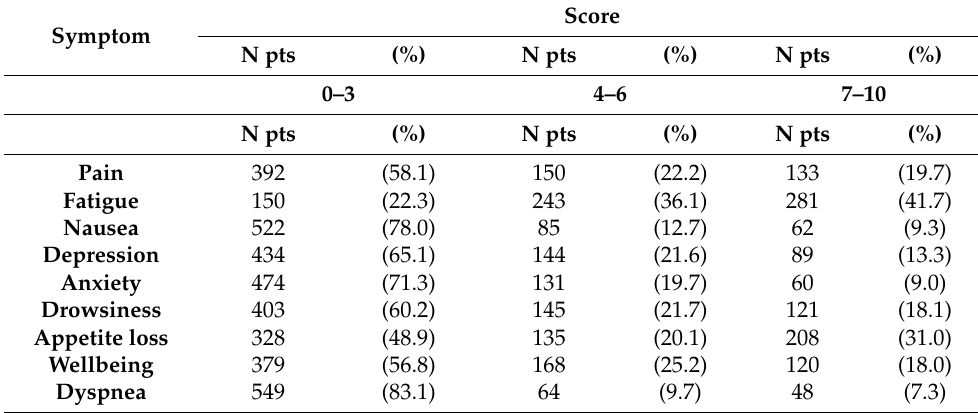
Table 2. Frequency distribution for the ESAS